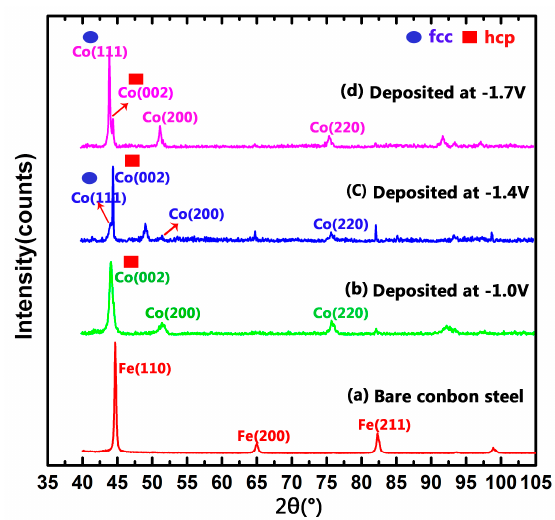
Figure 2. XRD patterns of ( a ) the bare carbon steel surface and the Co–Ni coatings for 3000 s under the applied potential of ( b ) − 1.0 V, ( c ) − 1.4 V, and ( d ) − 1.7 V in the mixed solution at room temperature.